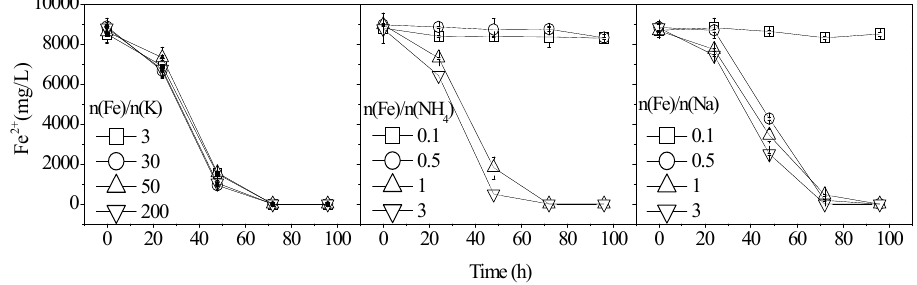
Figure 1. Effect of n(Fe)/n(M) (M: K, NH 4 , Na) on the Fe 2+ oxidation facilitated by A. ferrooxidans .